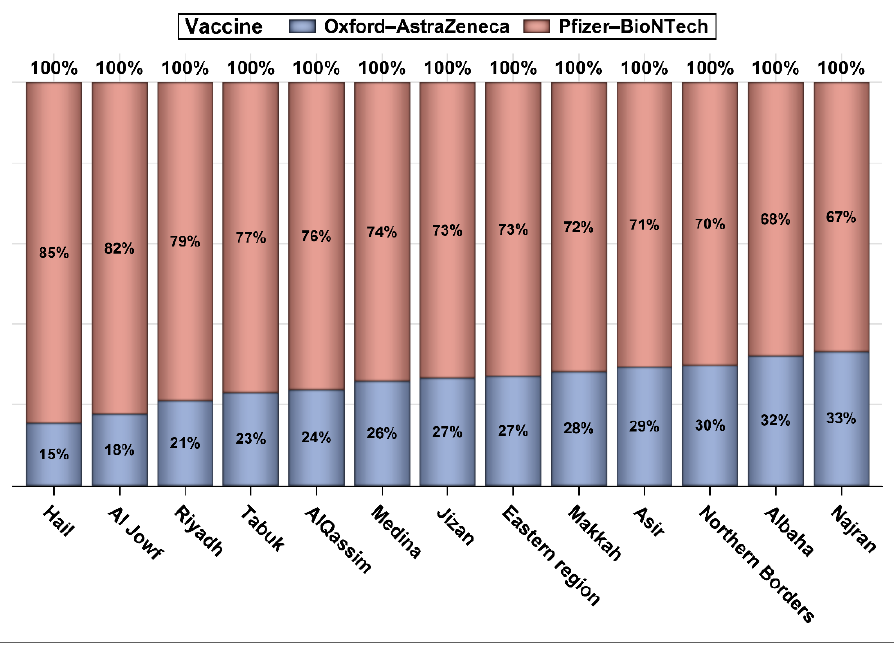
Figure 3. Percentage of persons in each region vaccinated with Pfizer–BioNTech and Oxford–AstraZeneca vaccines. Table 1. Persons’ baseline characteristics.